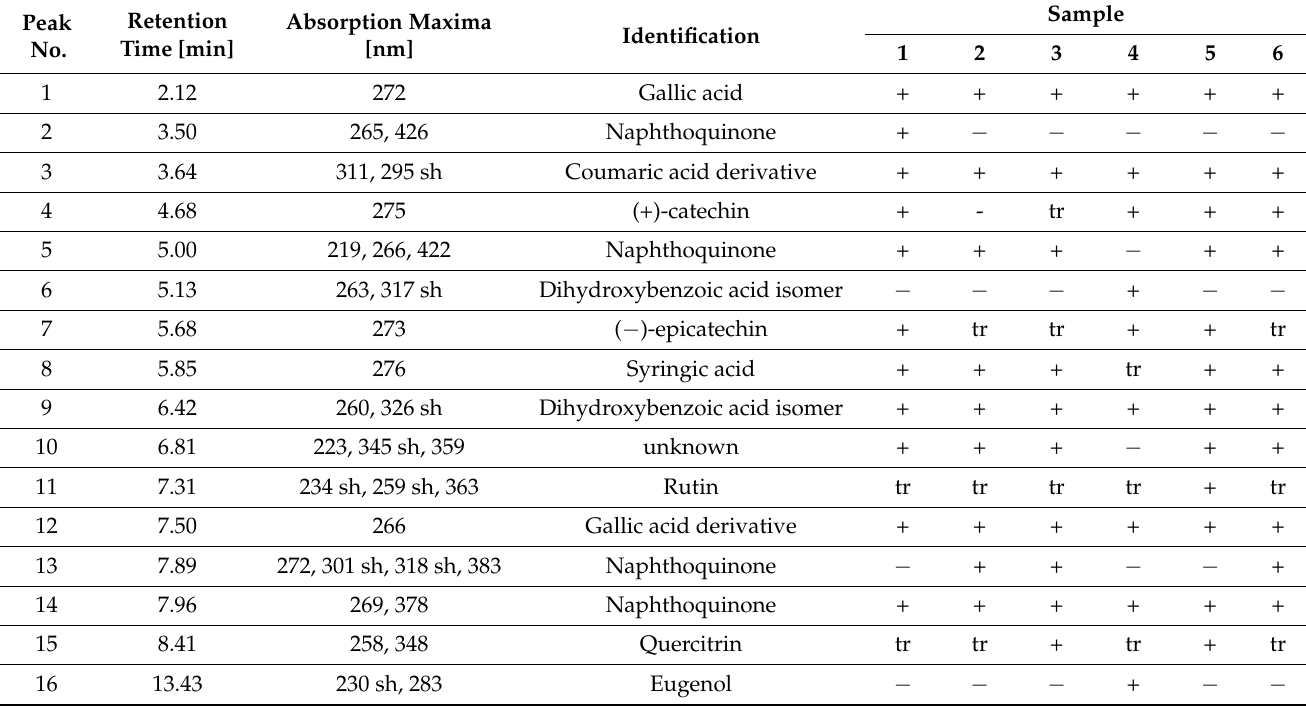
Table 4. Polyphenolic profiles of tested green wanut